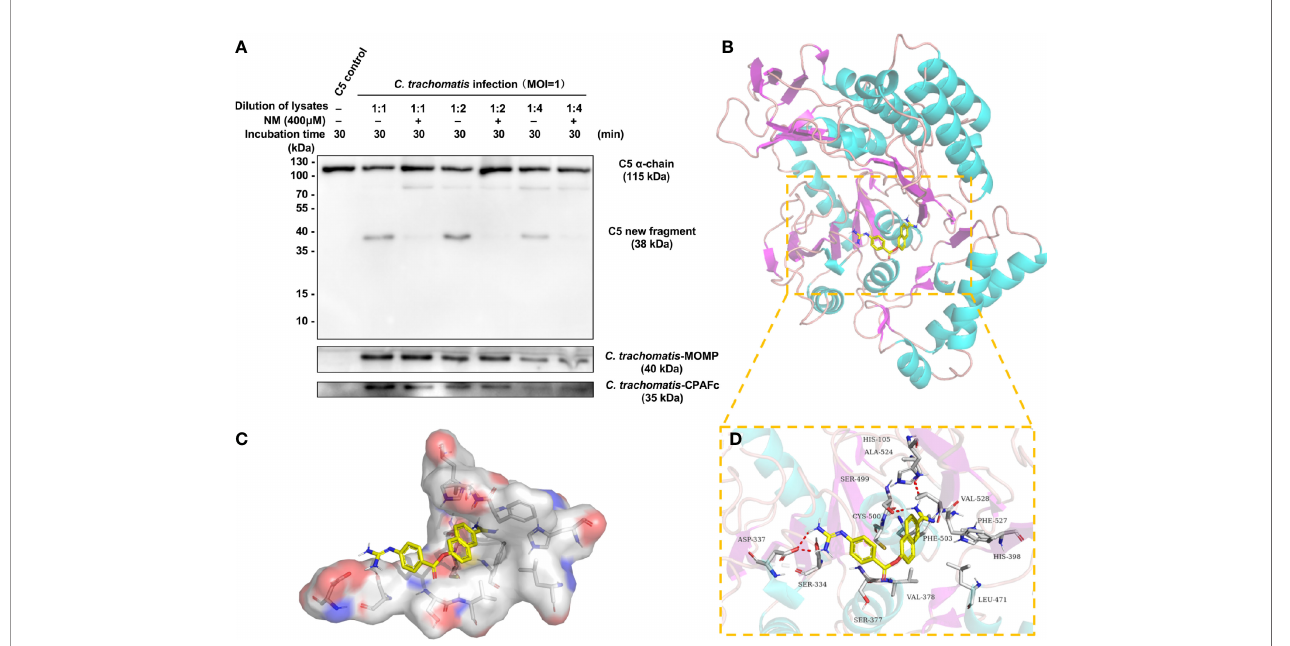
FIGURE 6 | NM inhibits the C3-independent C5 activation triggered by chlamydial infection and has a reasonable inhibitory conformation with CPAF. (A) NM (400 m M) was pre-mixed with different dilutions of C . trachomatis -HeLa229 cell lysates. Puri fi ed C5 was then incubated with PBS or the C . trachomatis -HeLa229 cell lysates for 30 min, respectively. The resulting products were subjected to immunoblot analysis against C5a, MOMP, and CPAFc. (B) The 3D structure of NM-CPAF complex. (C) The surface of the active site of CPAF. (D) The detail binding mode of NM-CPAF complex. The backbone of CPAF was rendered in tube and colored in bright blue. NM was colored in yellow. The hydrogen bonds in NM-CPAF complex were shown in red dashed